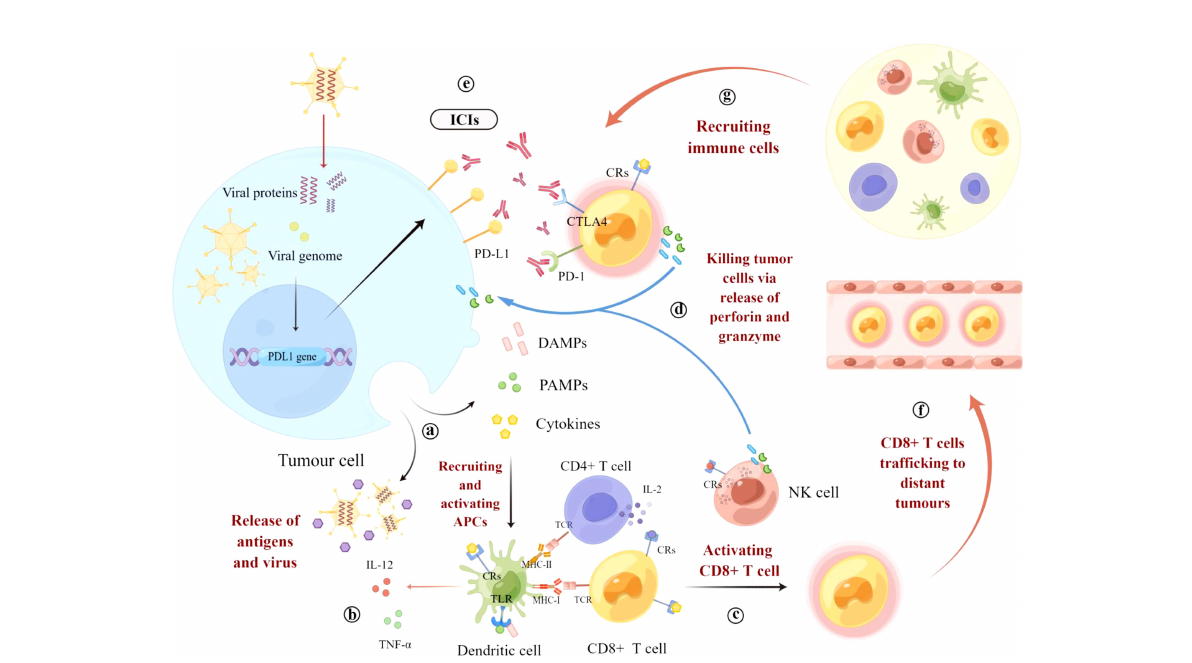
FIGURE 1 Mechanism of OVs combined with ICIs to stimulate anti-tumor immunity. (A) OVs enter tumor cells and undergo viral replication, leading to lysis and the release of danger-associated molecular pattern signals (DAMPs), pathogen-associated molecular patterns (PAMPs), tumor-associated antigens (TAAs), and pro-in fl ammatory cytokines. Viral progeny is also released, spreading to and infecting neighboring tumor cells. (B) These molecules recruit and activate antigen-presenting cells (APCs), such as dendritic cells (DCs), and promote the maturation of CDs through co- stimulatory markers while promoting the release of pro-in fl ammatory cytokines such as interleukin 12 (IL-12) and tumor necrosis factor (TNF- a ) from CDs and recognition by cytokine receptors (CRs) on T cells and NK cells. (C) Mature dendritic cells cross-present antigens to CD4+ and CD8 + T cells via the major histocompatibility complex (MHC) and induce their expansion and activation. (D) T cells and NK cells eventually lyse tumor cells by releasing perforin, granzyme, and cytokines (IFN- g , IL-2). (E) OVs infection leads to increased expression of immune checkpoint molecules such as PD-L1 and CTLA-4, thereby increasing the expression of the therapeutic targets of ICIs and sensitizing OV-infected tumor cells to ICIs. (F) In addition, local injection of OVs into individual tumor sites induces a distant effect, causing T cells to migrate to the site of metastatic disease, recognizing and killing distant tumor cells. (G) Cytokines and chemokines released in the tumor microenvironment can recruit immune cells for concerted anti-tumor